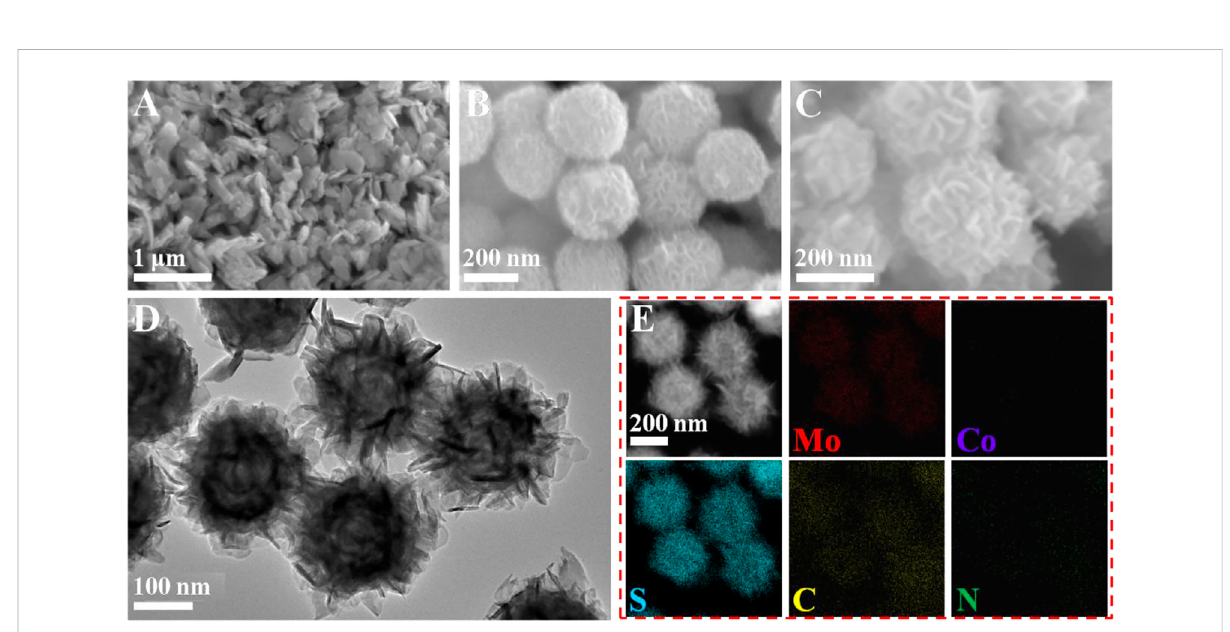
FIGURE 2 (A – C) SEM images of MoO 2 (acac) 2 /ZIF-67, MoCoS, and MoS 2 /Co 9 S 8 /C composites. (D) TEM image of MoS 2 /Co 9 S 8 /C. (E) TEM image of MoS 2 /